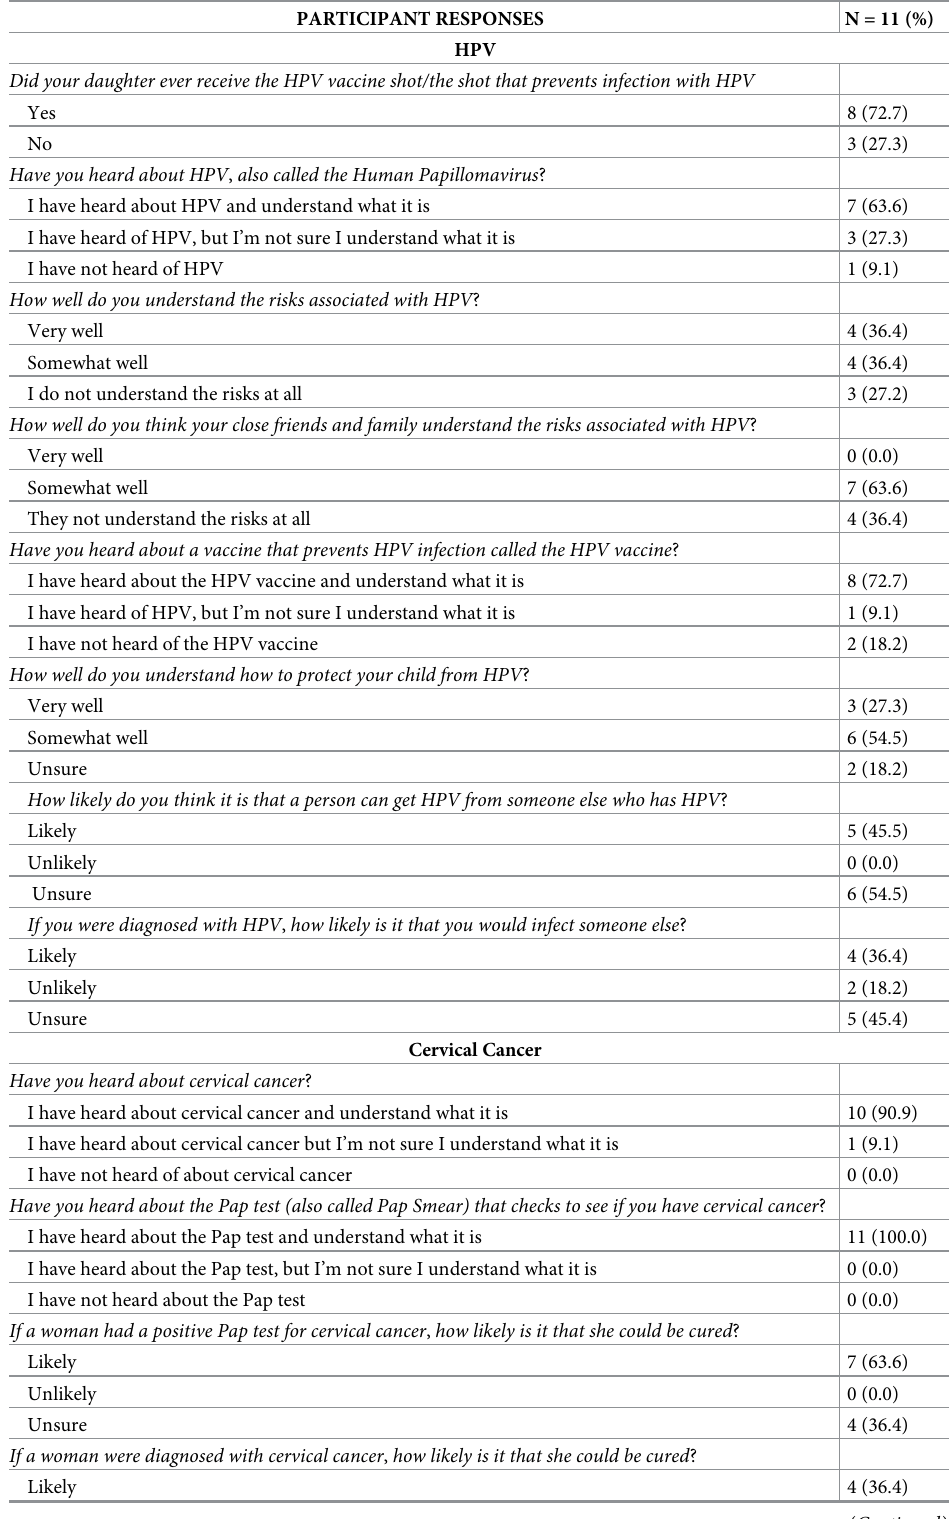
Table 2. Practices and knowledge related to cervical cancer